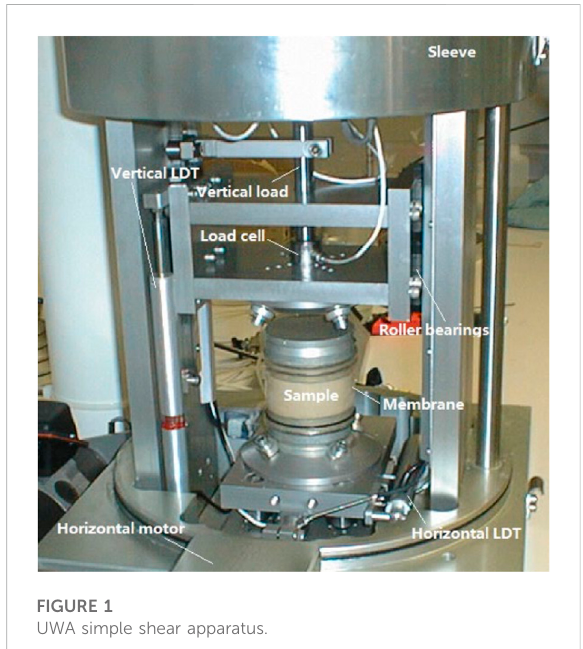
FIGURE 1 UWA simple shear